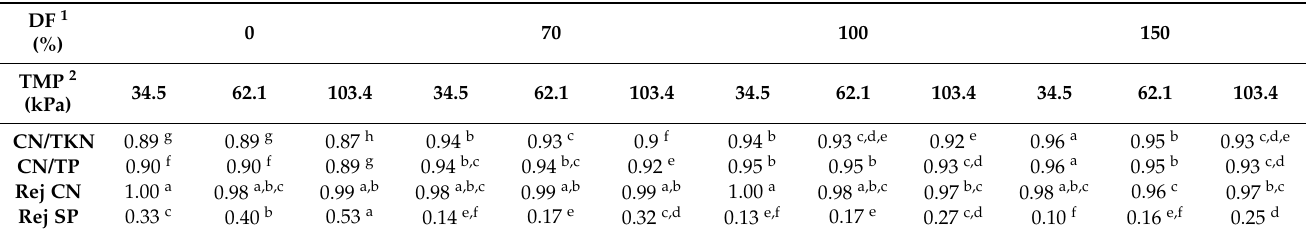
1 DF = diafiltration; 2 TMP = transmembrane pressure. a–h Mean values within same row not sharing a superscript are significantly different ( p < 0.05). Table 1. Mean ( n = 3) data on casein-to-total-protein ratio (CN/TKN), casein-to-true-protein ratio (CN/TP), rejection of casein (Rej CN) and of serum protein (Rej SP) obtained from the lab-scale experiments.